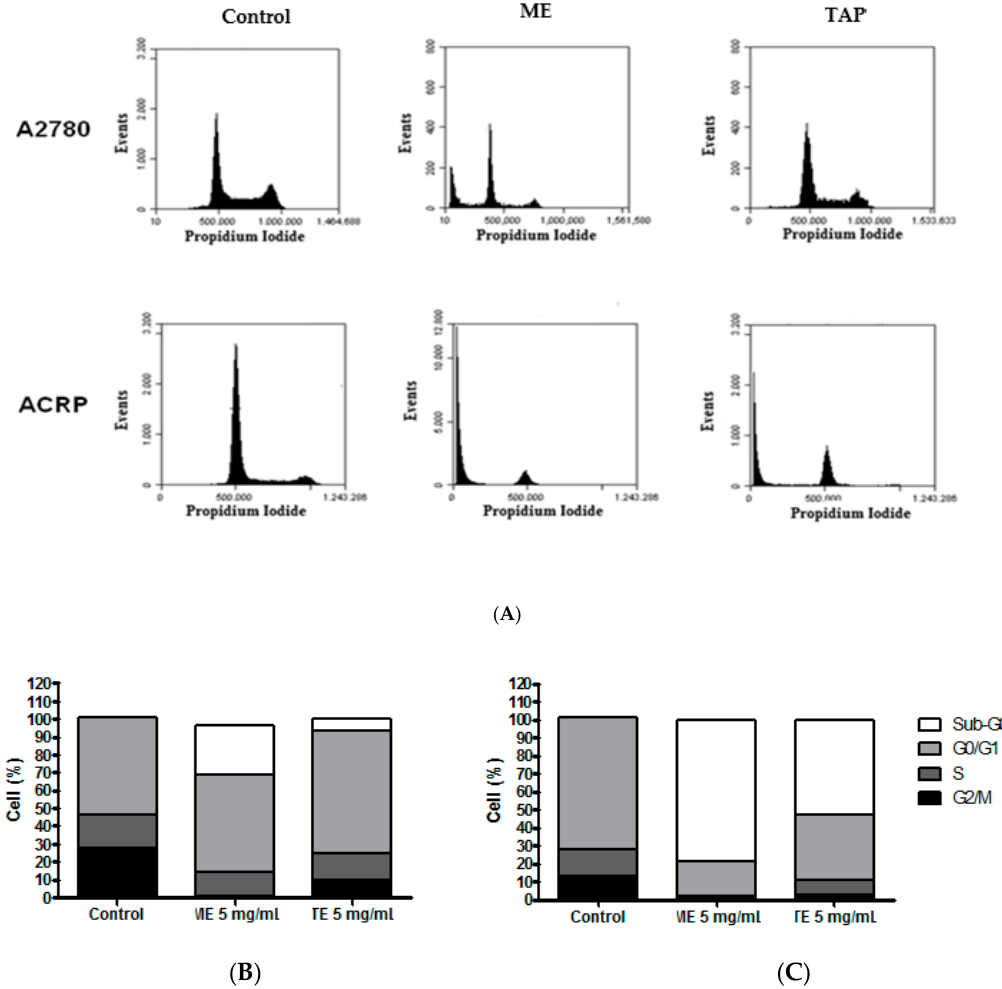
Figure 3. ME and TAP inhibit A2780 and ACRP cell cycle progression. A2780 and ACRP cells were tested for cell cycle progression in response to 24 h treatment with ME and TAP extracts ( A ). Flow cytometric analysis results are shown after treatment for 24 h with both cell extracts (5 mg / mL) and bar graphs represent the percentage of A2780 ( B ) or ACRP ( C ) cells in each cell cycle phase. The results are expressed as % of cells in sub-G 0 , G 0 / G 1 , S, and G 2 / M phases after cell treatment with ME or